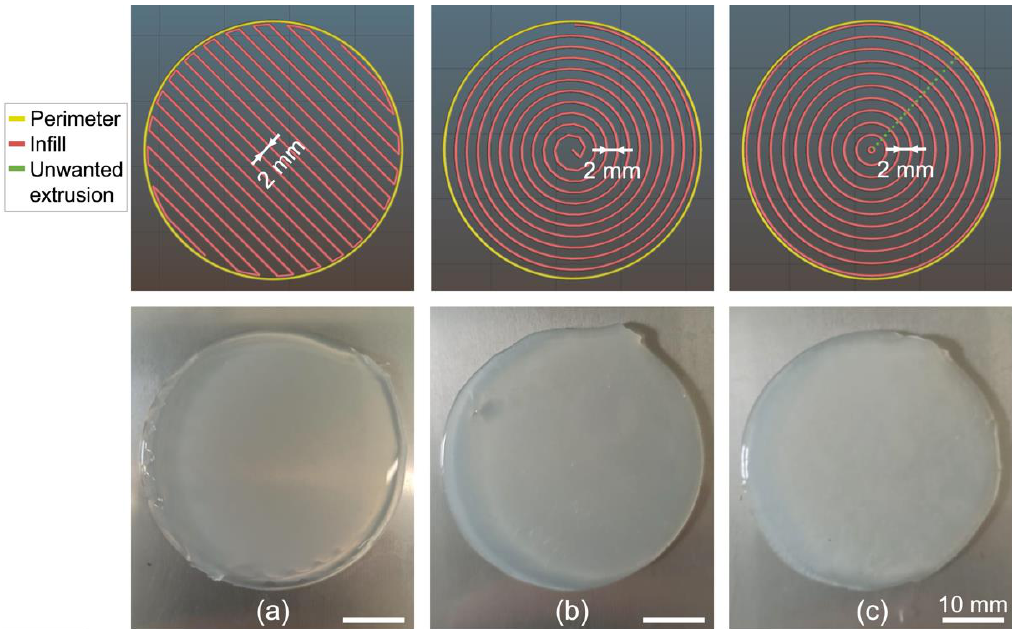
Figure 7. Tests to determine the optimal infill pattern in the case of a 40 mm diameter disc with an infill density adjusted to obtain a 2 mm line separation. ( Top ) Printing paths generated in Slic3r. ( Bottom ) Corresponding prints for ( a ) rectilinear with 27% infill density; ( b ) Archimedean chords with 30% infill density; and ( c ) concentric with 27% infill density. Silicone: Ecoflex 00-20. Needle diameter: 1.6 mm. Printing speed: 30 mm/s. Extrusion speed: 0 mm/s. Bed temperature: 90 ◦